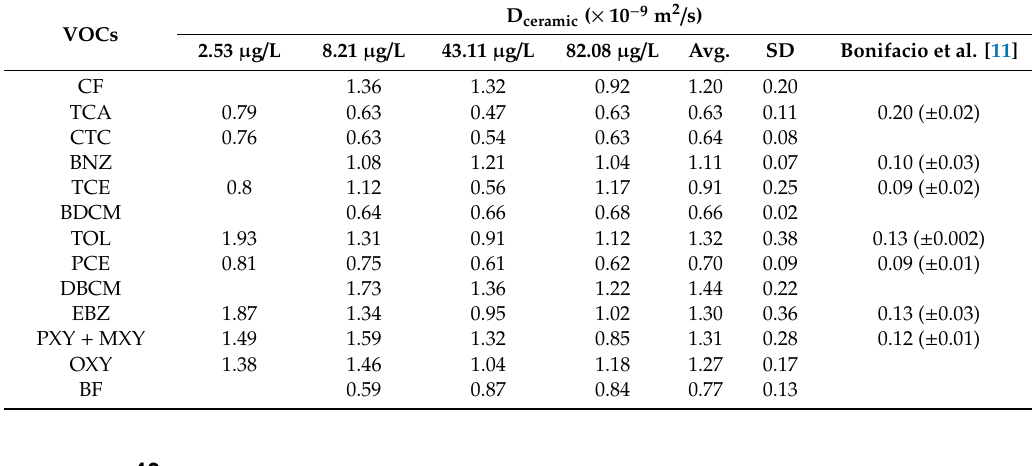
Table 4. Average D ceramic values at various concentrations in this study and in a previous study. VOCs